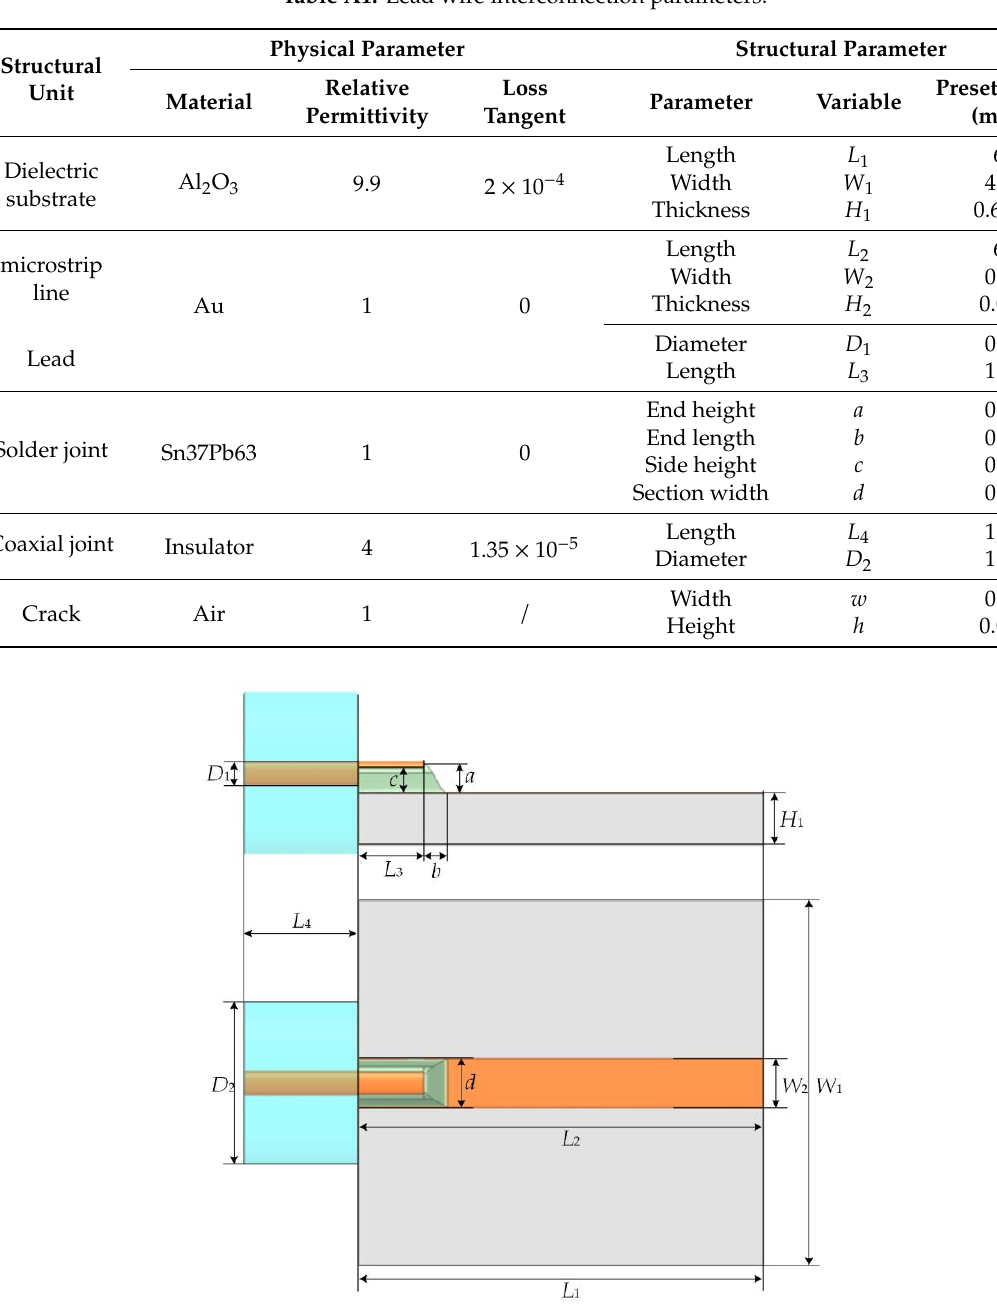
Table A1. Lead wire interconnection parameters.